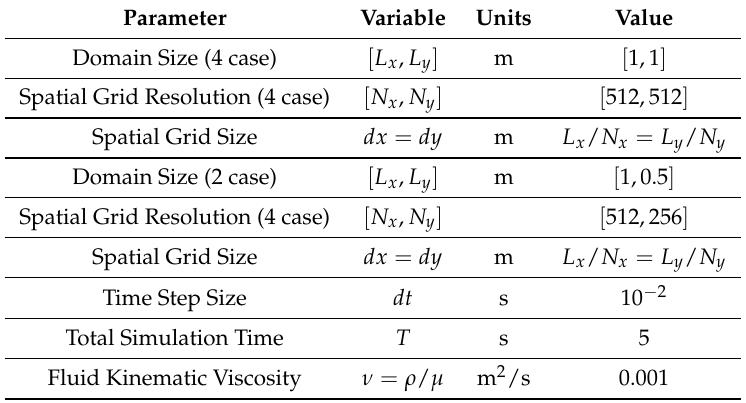
Table 5. Numerical parameters for the 4 interacting vortices